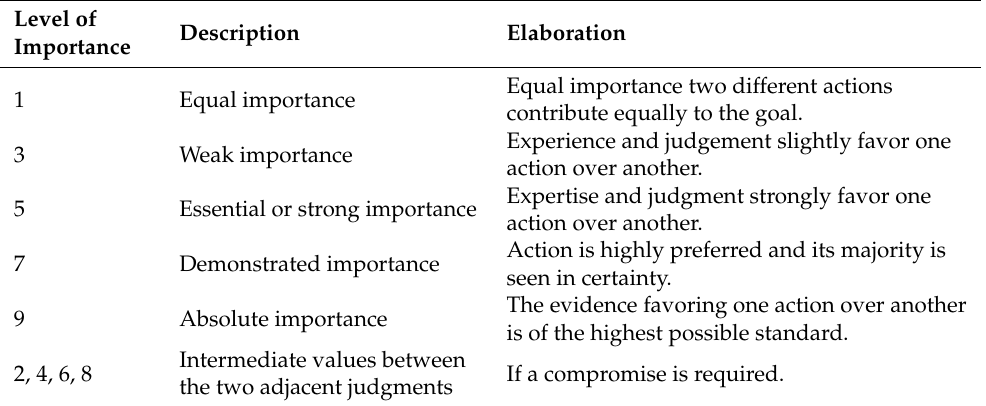
Table 5. Nine scales of pairwise comparisons.